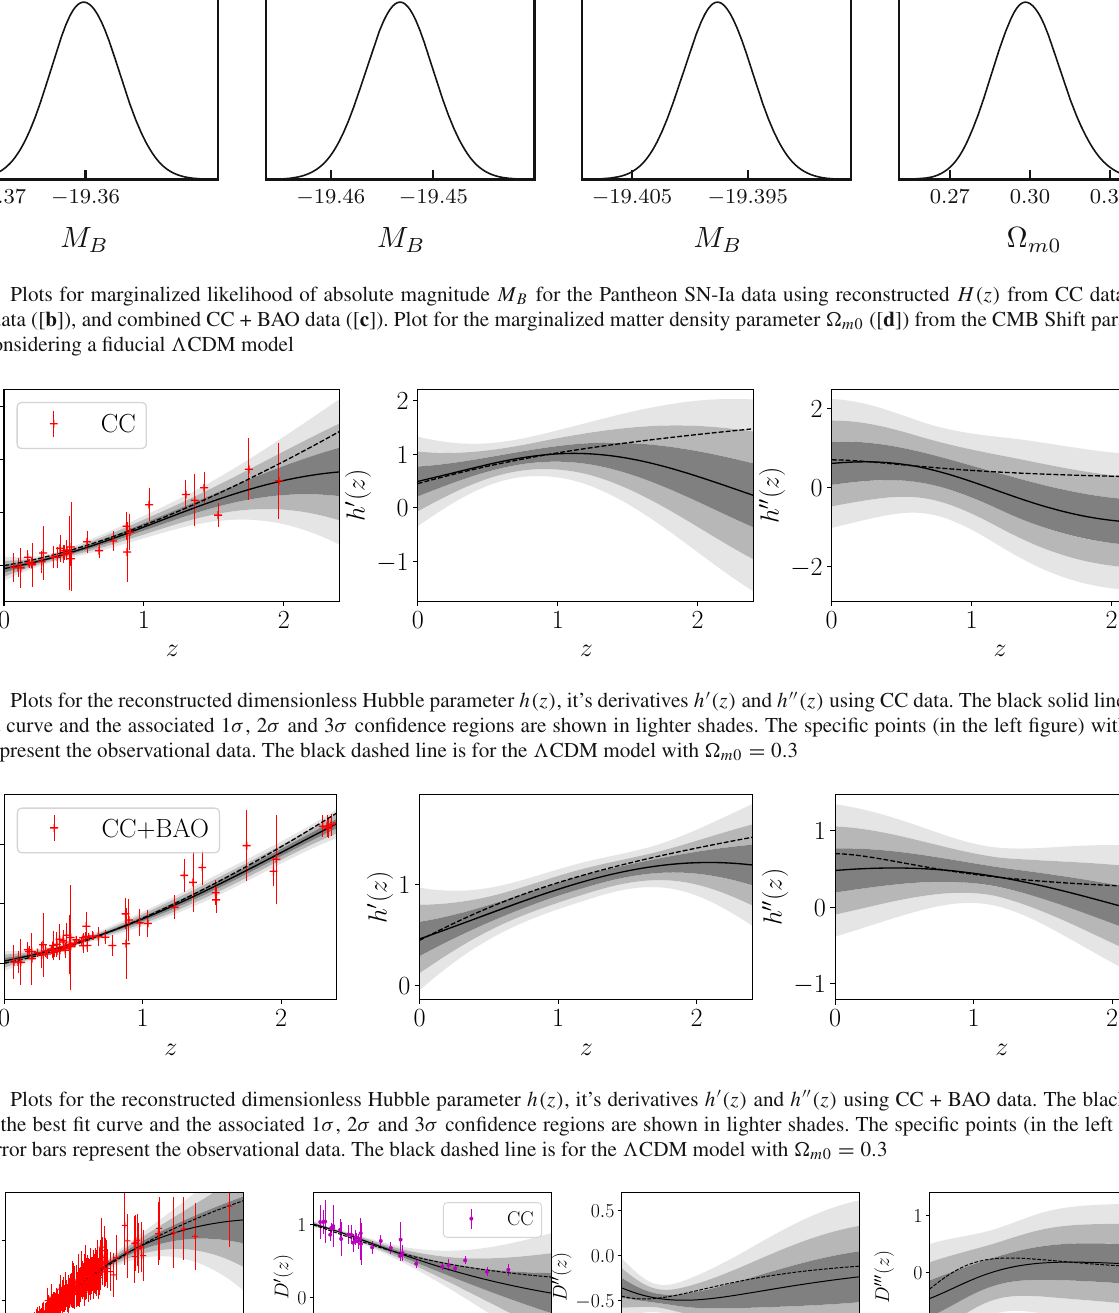
0 . 2 z Fig. 5 Plots for the reconstructed dimensionless co-moving luminosity distance D ( z ) , it’s derivatives D (cid:3) ( z ) , D (cid:3)(cid:3) ( z ) and D (cid:3)(cid:3)(cid:3) ( z ) using the Pantheon data. The black solid line is the best fit curve. The associated 1 σ , 2 σ and 3 σ confidence regions are shown in lighter shades. The specific points (in the top two figures) with error bars represent the observational data. The black dashed line is for the (cid:2) CDM model: (cid:12) m 0 = 0 .